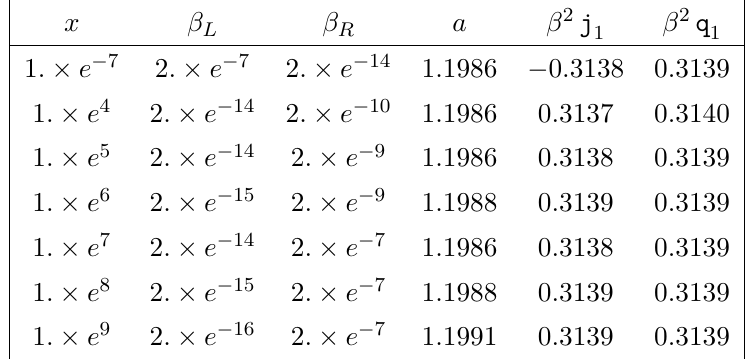
Table 2 . Investigation of the energy current and energy density when connecting two CFTs of central charges 1 and 1 : 2. In the last two columns we chose (cid:12) = min( (cid:12) L ; (cid:12) R ). a net positive energy current. As usual, a similar argument can be made for the (cid:0)